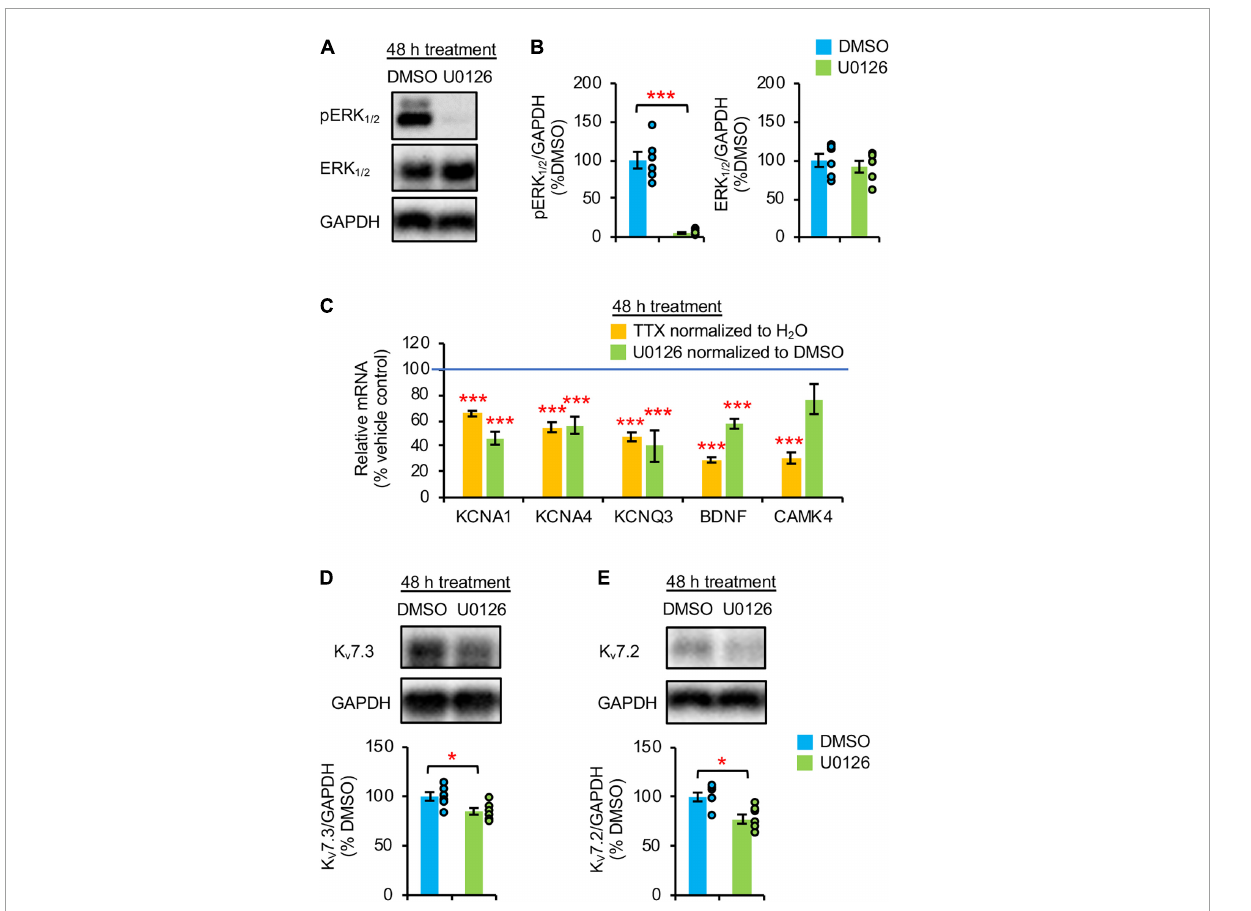
FIGURE2 Prolonged pharmacological inhibition of ERK1/2 decreased mRNA and protein expression of K v 7.3. (A,B) Cultured hippocampal neurons (DIV 10) were treated for 48 h with vehicle control (0.1% v/v DMSO) or 20 µ M U0126. Immunoblot analysis was performed with antibodies for pERK 1 / 2 (pERK1 Thr 202 / Tyr 204 /pERK2 Thr 185 / Tyr 187 ), ERK 1 / 2 , and GAPDH ( n = 6 per treatment). (A) Representative immunoblots. (B ) Quantification of pERK 1 / 2 and total ERK 1 / 2 immunodensities normalized to vehicle control. (C) Both TTX and U0126 treatment for 48 h decreased BDNF and KCNQ3 expression. Cultured hippocampal neurons (DIV 10) treated for 48 h with 1 µ M TTX or its vehicle control (0.1% H 2 O), and 20 µ M U0126 or its vehicle control (0.1% DMSO). QPCR was performed using the cDNA which was prepared from 2 µ g of total RNA isolated from cultured neurons and validated primers for Kcna1, Kcna4, Kcnq3, Bdnf, Camk4, and Gapdh ( n = 5 per treatment). Data were analyzed using the comparative threshold cycle (Ct) method and Gapdh internal control gene. Following normalization to Gapdh cDNA levels (which is reflected in the (cid:49) Ct values), the relative mRNA quantification (RQ) of the fold change for each condition compared to reference control was determined using the following equation: RQ = 2 ( – (cid:49) Ct ) /2 ( – (cid:49) Ctreference ) . The RQ data is shown as mean ± SEM. One-way ANOVA with Tukey post hoc was used (*** p < 0.005). (D,E) ERK1/2 inhibition for 48 h decreased K v 7.3 and K v 7.2 expression. Hippocampal cultured neurons (DIV 10) were treated for 48 h with 20 µ M U0126 or its vehicle control (0.1% v/v DMSO) and subjected to immunoblot analyses with the verified antibodies for K v 7.3 ( Supplementary Figure 4 ) and antibodies for K v 7.2 and GAPDH ( n = 6 per treatment). (D) Representative Immunoblot and quantification